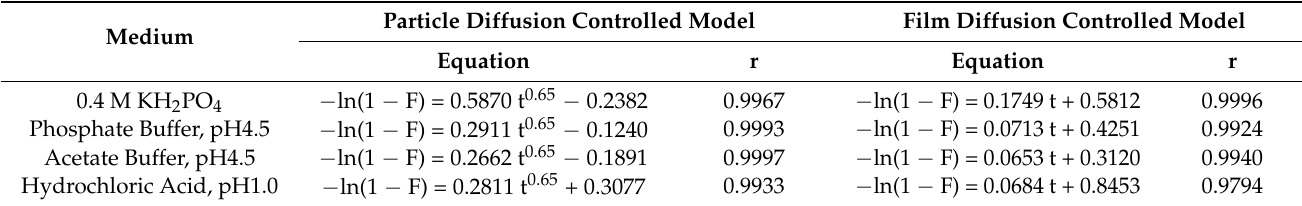
Table 3. Kinetic parameters for release